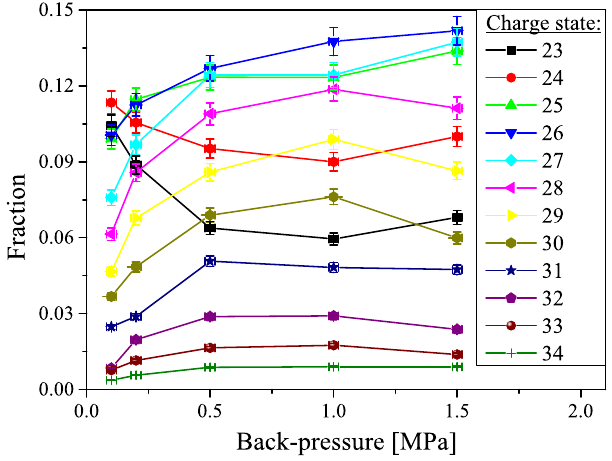
FIG. 9. Measured charge state fractions for 238 U on O 2 gas at 1 . 4 MeV = u, corresponding to the charge state distributions shown in Fig. 7(a).